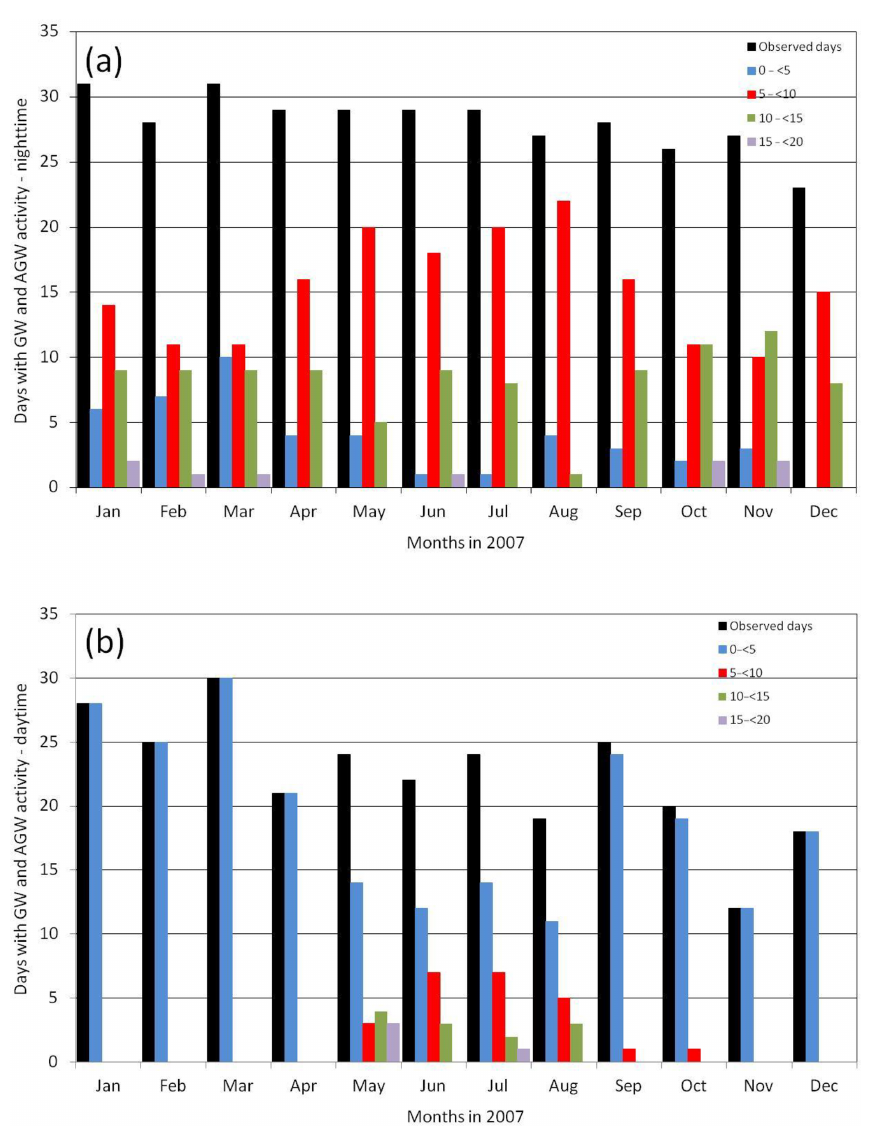
Figure 6. Monthly small-scale wave activity at EACF as detected in the low ionosphere using VLF technique during 2007 during night (a) and daytime (b) hours. The black bar shows the number of the observed days per month, and the colored bars show the number of nights and days per month with GW events observed according to the wave predominant periods. The bar colors give the number of waves with predominant period observed in each month separated as the following period intervals: 0–5 (blue), 5–10 (red), 10–15 (green), and 15–20min